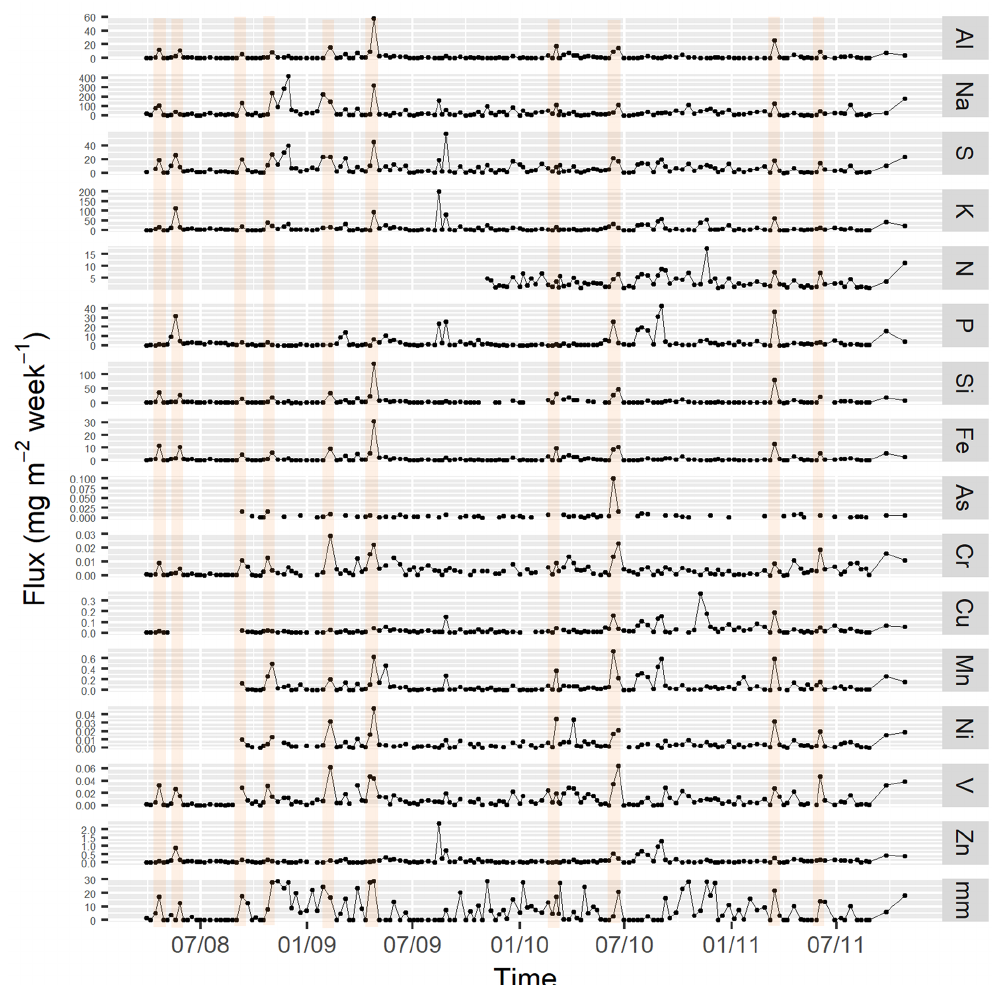
Figure 1. Temporal variability in bulk weekly fluxes from March 2008 to October 2011 for main markers, nutrients, and trace metals and rainfall during the same period. The 10 most intense dust events are displayed in the boxes in orange (see details in Sect.